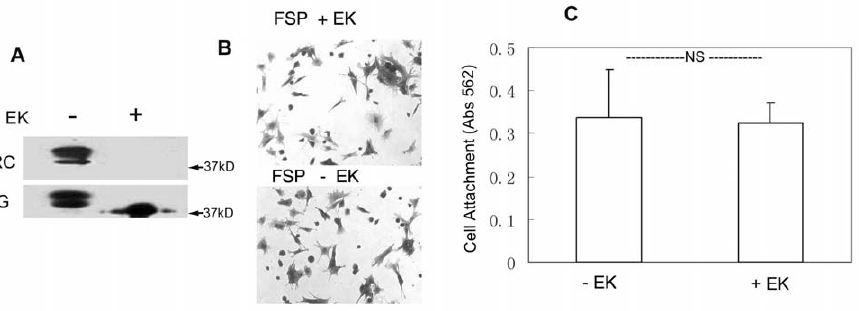
Figure 4. The adhesive effect of FSP was not affected by the FLAG tag. FSP treated with ( + ) or without ( 2 ) enterokinase (EK) was resolved by SDS-PAGE under non-reducing conditions and was immunoblotted with anti-FLAG IgG or anti-SPARC IgG ( A ). FSP (10 ug/ml) with( + ) or without ( 2 ) EK was coated onto 96-well plates overnight at 4 u C. LEC were plated into the wells and incubated in serum-free DMEM for 2 hr at 37 u C. Cells were stained with crystal violet ( B ); cell attachment was also quantified by a colorimetric assay at 562 nm ( C ). Results are mean + / 2 SD of experiments carried out in triplicate. NS, not significant ( P . 0.05).